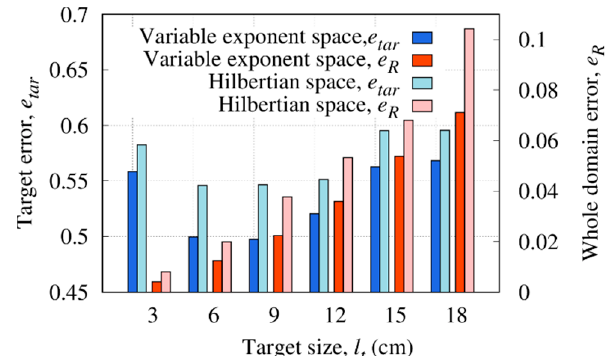
Figure 8. Reconstruction errors in the whole investigation domain and inside the target region versus target size, 𝑙 (cid:3047) with the variable exponent approach and classical Hilbertian space.